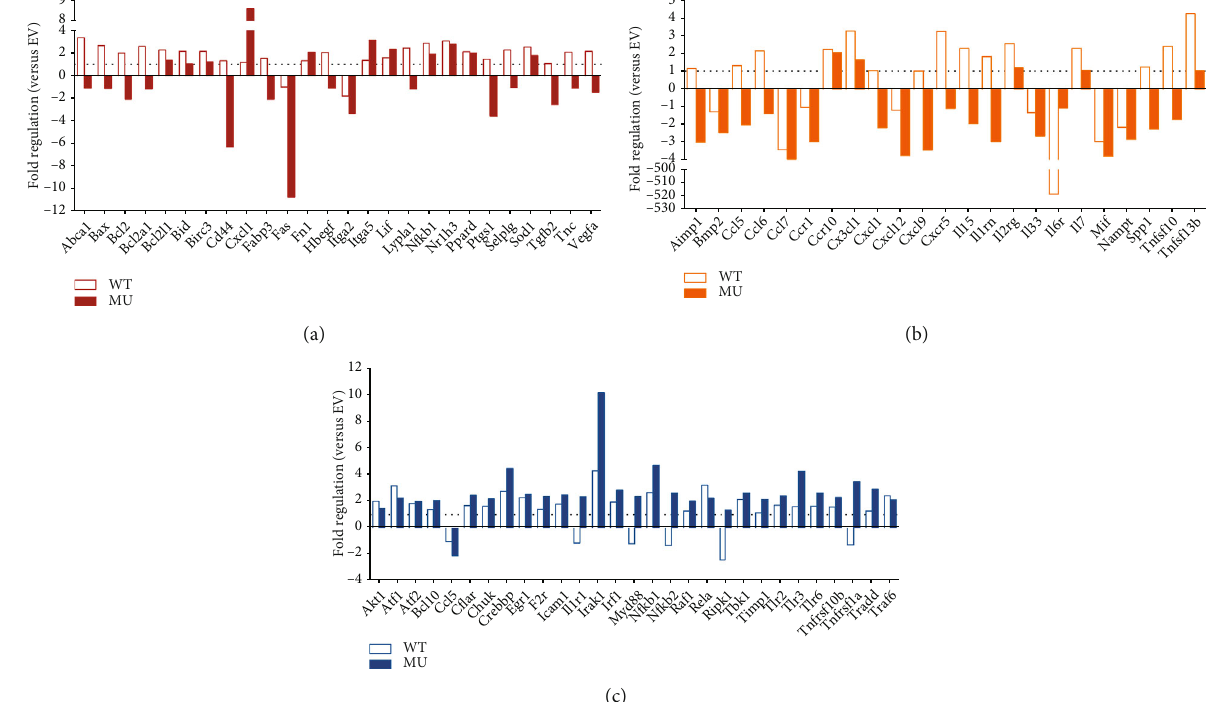
Figure 5: The fold regulation of di ff erential expression genes (DEGs) in WT and MU groups compared to EV group. (a) Rat atherosclerosis- related DEGs. (b) Rat in fl ammatory cytokines and receptor-related DEGs. (c) Rat NF- κ B pathway-related